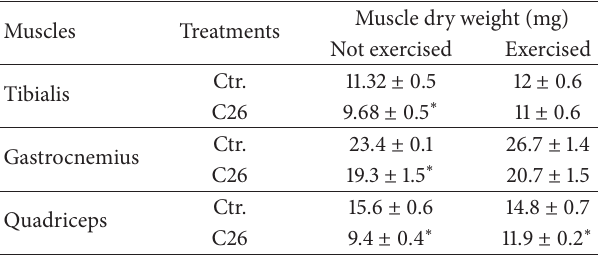
Ctr. Ctr. Ctr. C26